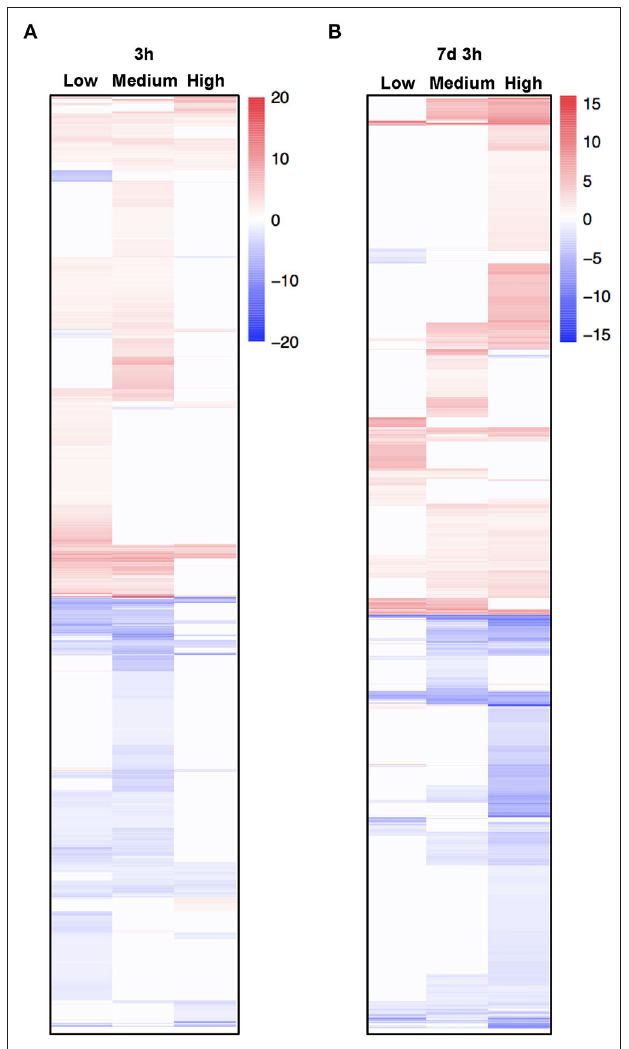
FIGURE 6 | Heatmap of coregulated genes in response to different salt concentrations. (A,B) Heat map of differentially expressed genes (DEGs) commonly regulated under salt stress of all levels. The color scale in the heat map indicates the log-ratio of the normalized gene expression value in each sample to that in mock